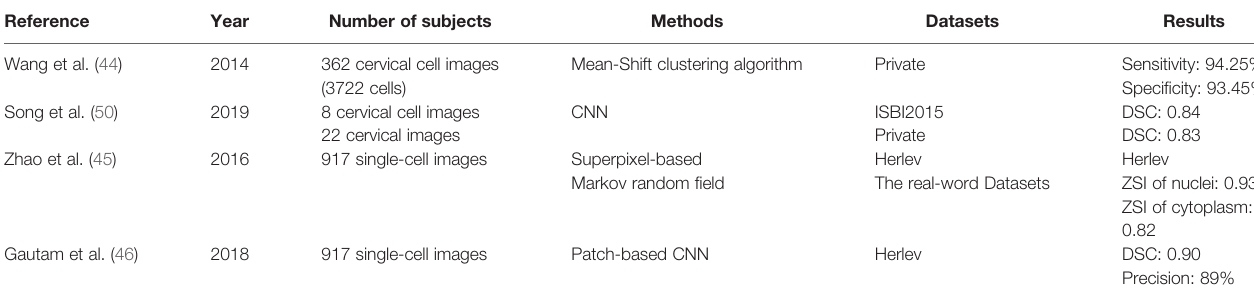
TABLE 3 | Application of AI in cervical cell segmentation.